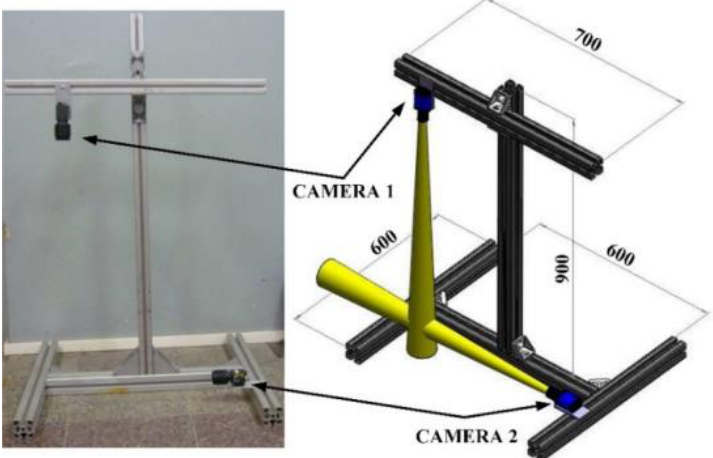
Figure 4. Realized technical solution experimental measurement stand with CCD cameras.